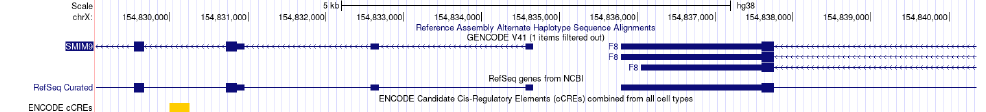
Figure 3. Genomic region of SMIM9 gene. The figure shows there are no prom signature regions, in the proximity of the TSS of SMIM9, in the cCREs track, meaning it would be left out from the gene activity computation if looking only at Promoter signatures.